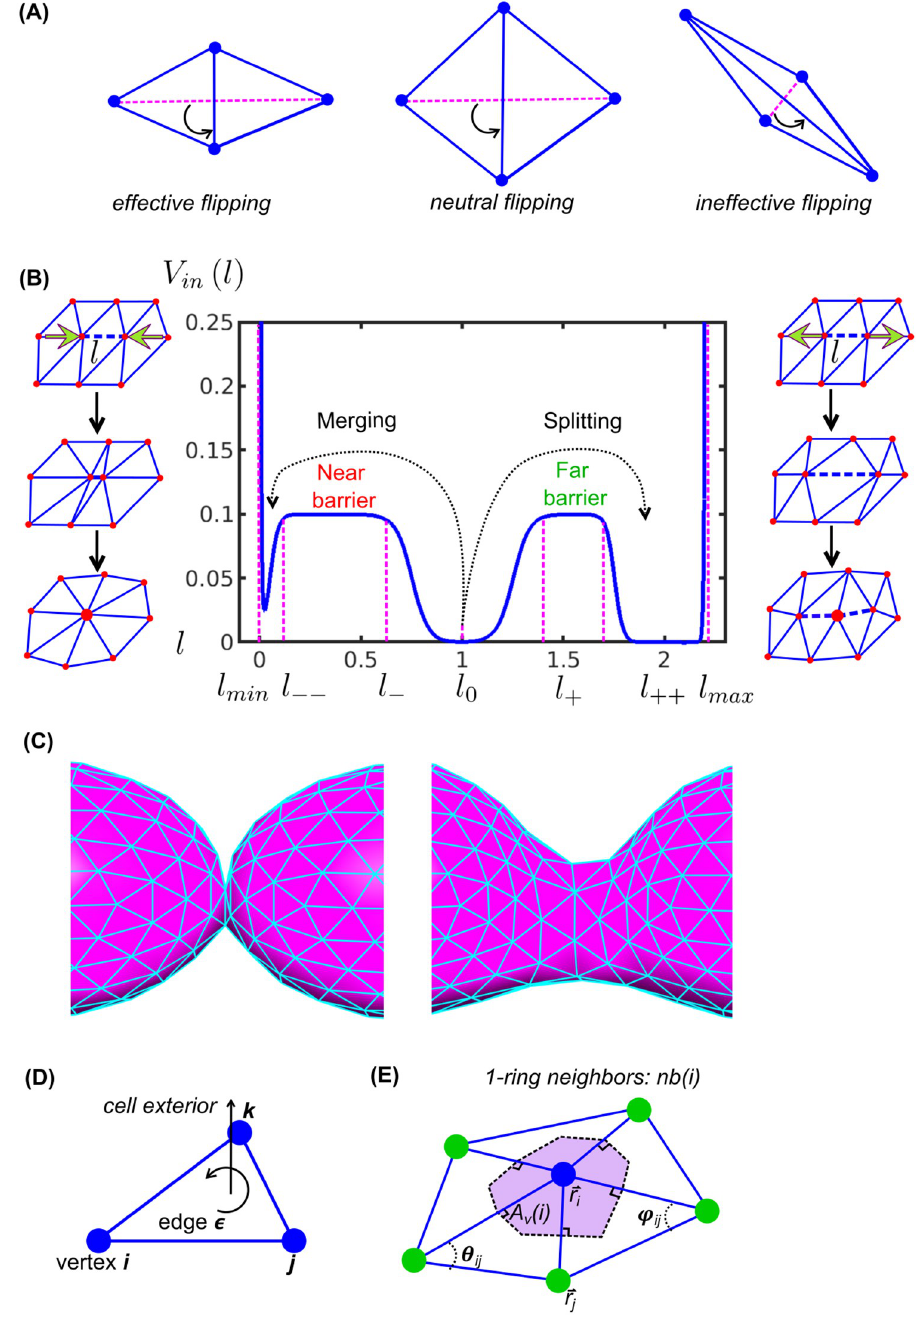
Fig 2. Remeshing controlled by barrier crossings in a double-barrier potential. (A) Remeshing via flipping procedures. (B) Remeshing via splitting and merging procedures controlled by barrier crossings in a potential V in at indicated lengths. (C) Initial triangular meshes and high-quality triangular mesh after relaxation. (D) Triangular mesh element: right-hand rule. (E) Definition of 1-ring neighbors nb ( i ) and Voronoi area A v in purple [30]. r i and r j are the vectors defined by vertex i and j , and θ ij and ϕ ij are the two angles for computing the discrete Helfrich energy at i Eq (5).